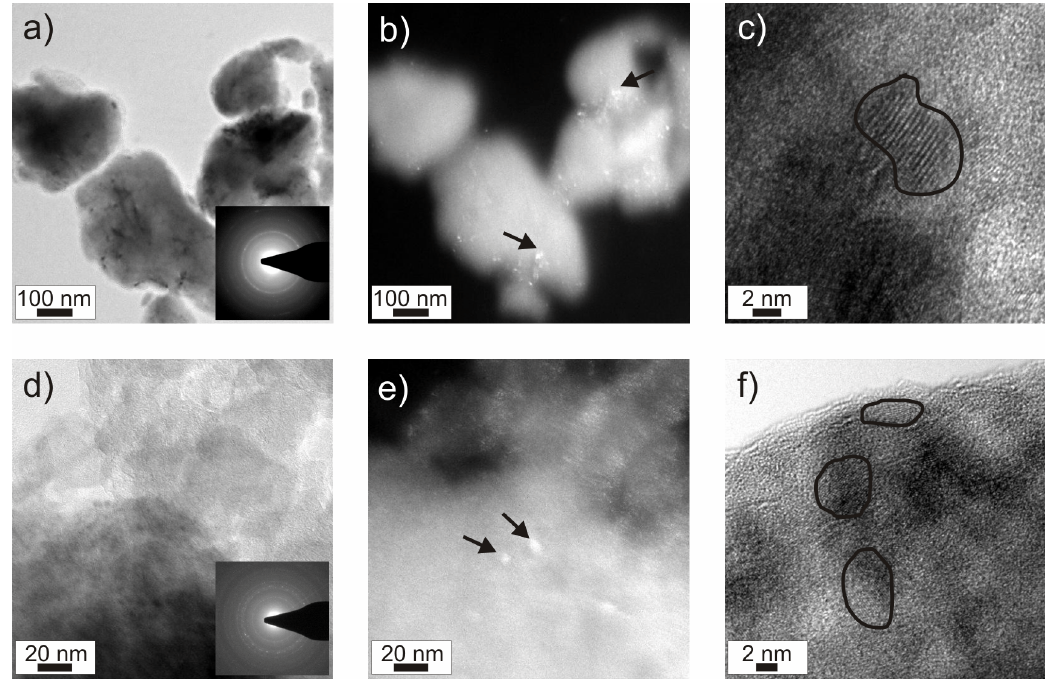
Figure 3. TEM investigation of powder P1 ( a – c : as-milled; d – f : after galvanostatic cycling): ( a , d ) Brightfield images showing typical powder particles (inserted: diffraction patterns); ( b , e ) Darkfield images: The bright spots indicate nanocrystals, some of them are marked by arrows); ( c , f ) High resolution micrographs showing some of the nanocrystals indicated by visible lattice fringes (highlighted by black lines).